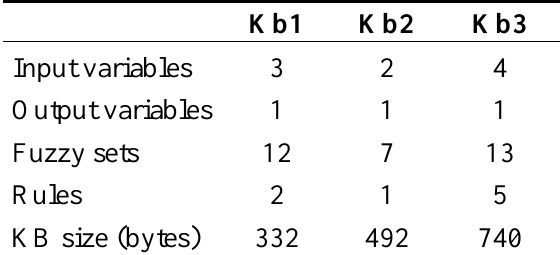
Table 2. Knowledge base